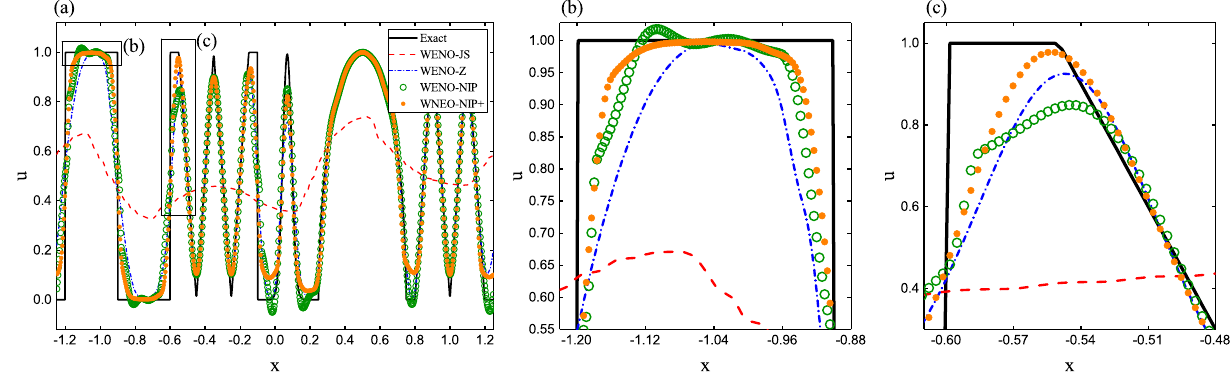
Figure 6. ( a ) Results of the ZWACM linear test with t = 2500 (1000 cycles) and N = 800. ( b ) Zoomed- in view of the top of the square wave. ( c ) Zoomed-in view of the concerned region as marked in ( a ).